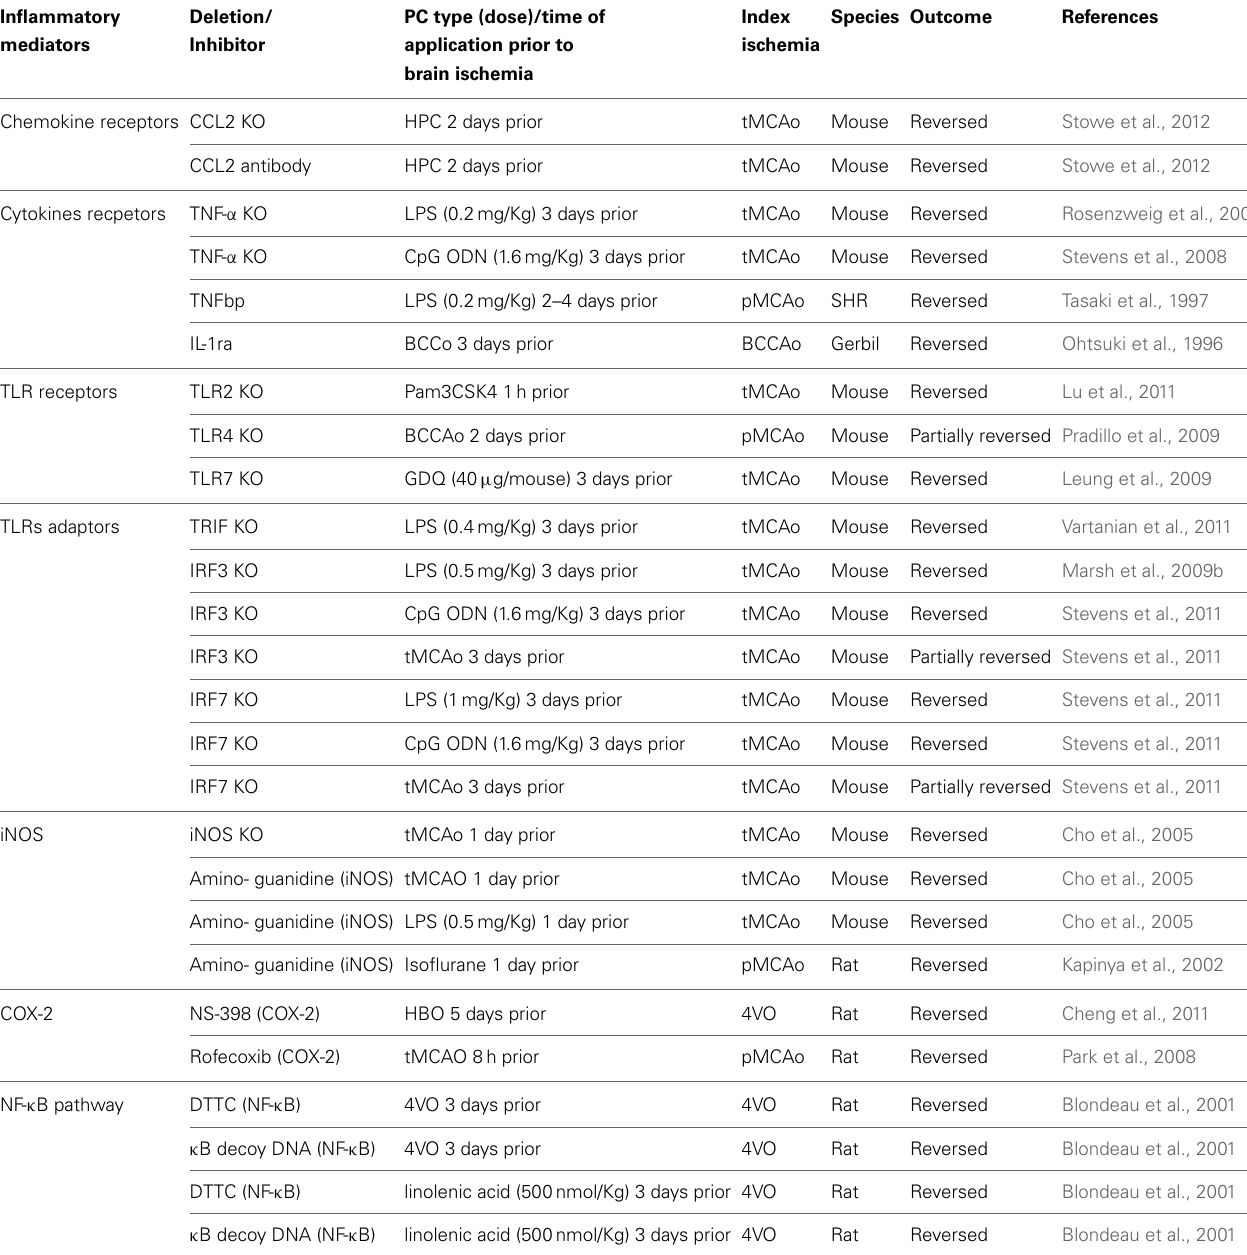
Table 3 | Evidence for the involvement of inflammatory mediators in